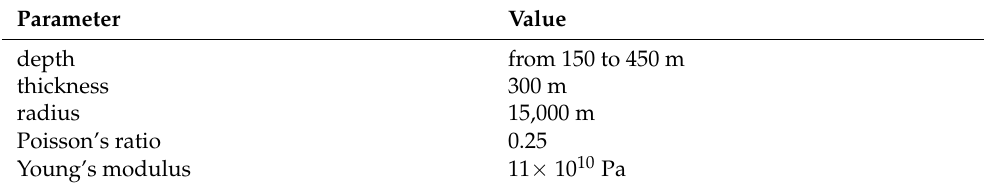
Table 2. Characteristics of the aquifer as input to the Geertsma